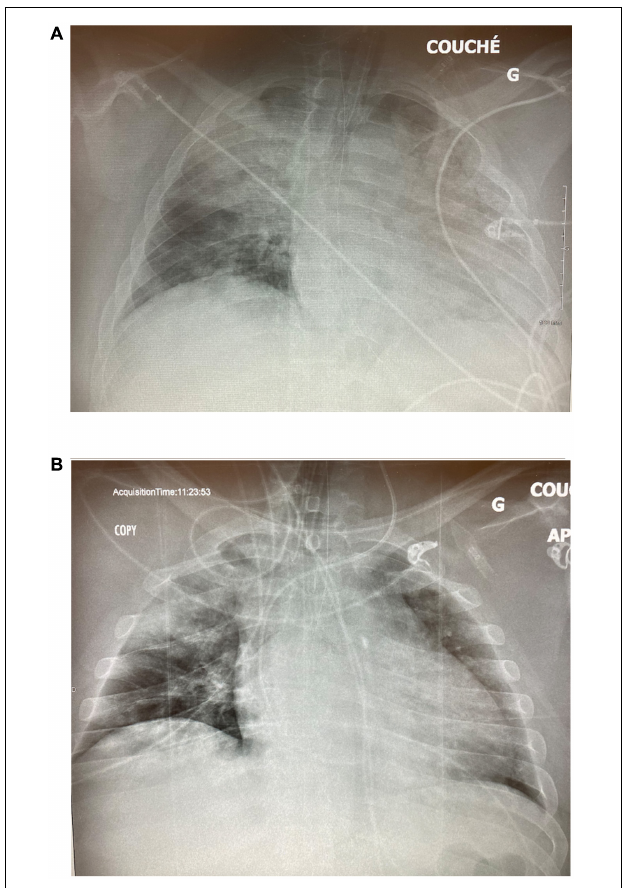
FIGURE 5 | Case 2: (A) Day 1, 1 h post APRV-TCAV. (B) Day 2, approximately 30 h after initiaition of